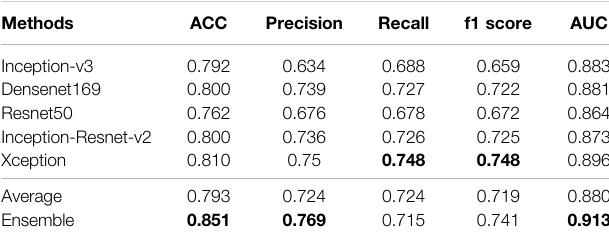
TABLE 3 | Results of different networks and two ensemble methods on multi- classi fi cation task. (The bold numbers in the table of this article are the maximum values of their